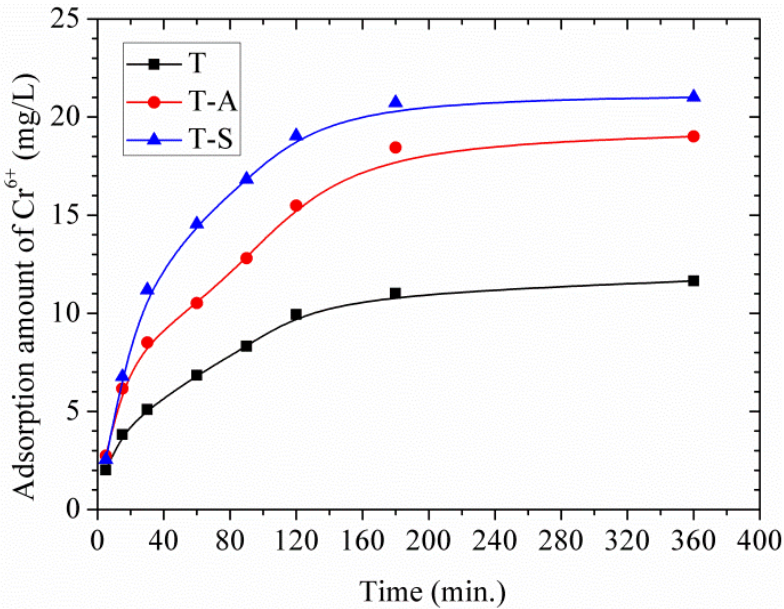
Figure 9. Effects of contact time on adsorption amount of Cr(VI). Table 2. A comparison of pseudo-first-order and pseudo-second-order kinetic model for the Cr(VI) adsorption by tobermorite.